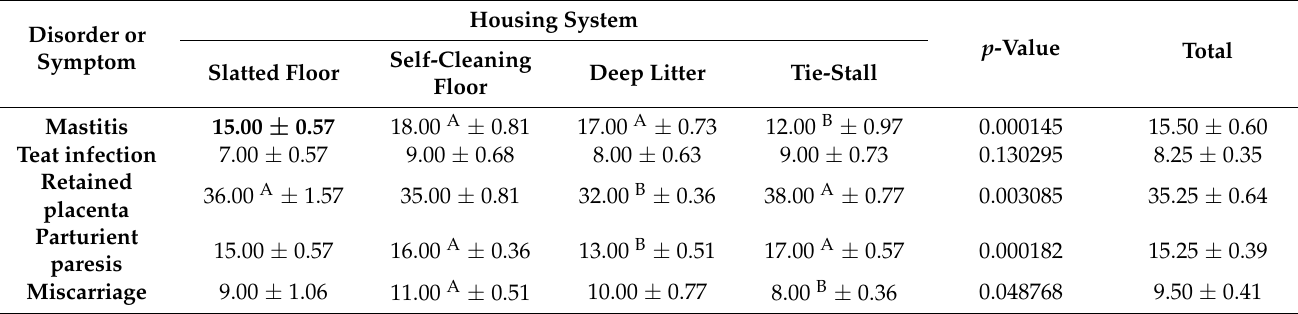
Figure 8. Prevalence of limb disorders in dairy cows kept in different housing systems in 2015–2020. An analysis of the average morbidity (Table 5) and prevalence (Figure 9) of mastitis and reproductive disorders in different housing systems indicates that the risk of retained placenta and parturient paresis was significantly lower on deep litter ( p ≤ 0.01). Retained placenta (the most common reproductive disorder in this study) was significantly more prevalent in the tie-stall system and in the free-stall barn with a slatted floor ( p ≤ 0.01). In turn, the tie-stall system was characterized by a lower risk of mastitis than the open- pack barns with deep litter and a self-cleaning floor ( p ≤ 0.01). Mastitis was also less prevalent in the barn with a slatted floor than in systems with deep litter and a self-cleaning floor, although the noted differences were not statistically significant. No differences in morbidity linked to teat infections were observed among groups. The number of miscarriages was significantly higher in herds kept on a self-cleaning floor than in the tie-stall system ( p ≤ 0.01). Table 5. Mammary gland and reproductive disorders in dairy cows kept in different housing systems in 2015–2020 (mean ±